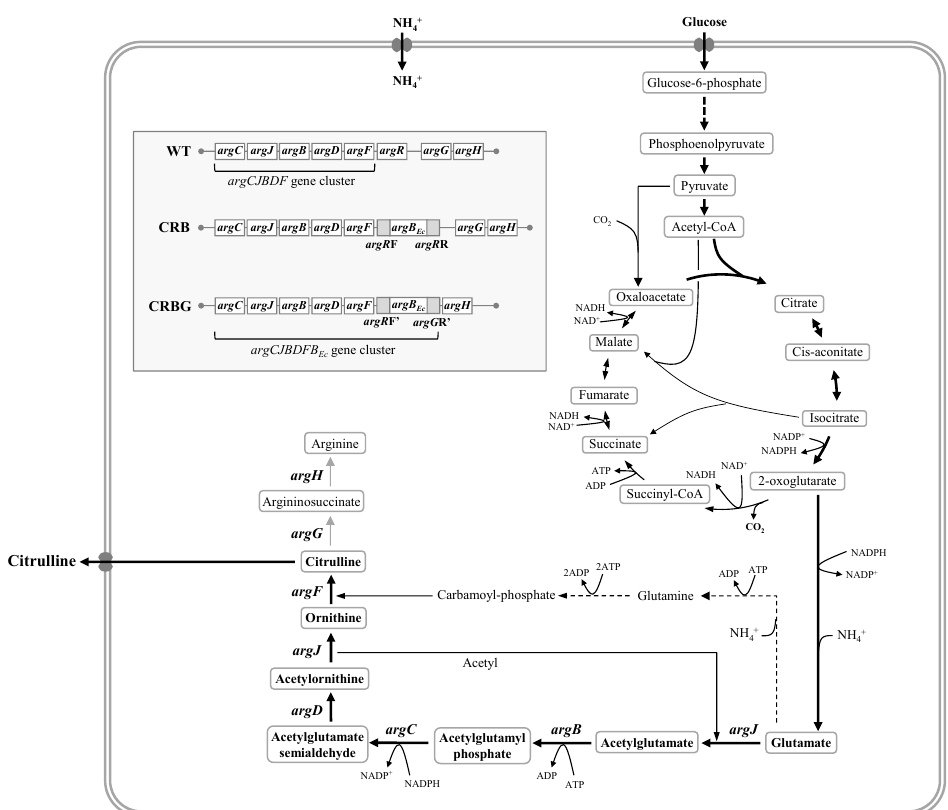
Figure 1. Schematic representation of the L-citrulline biosynthesis pathway in C. glutamicum and the modifications of the genome.